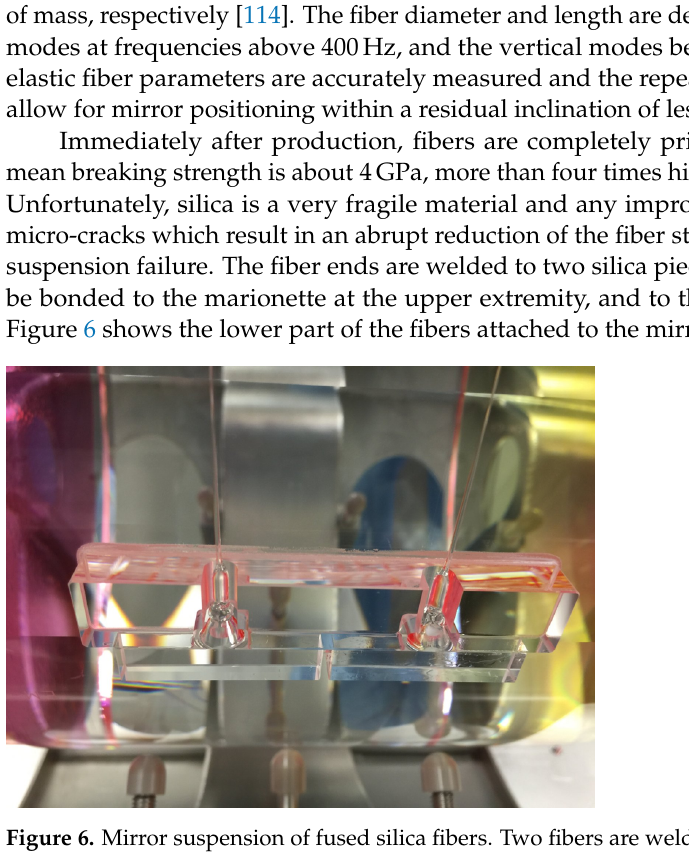
Figure 6. Mirror suspension of fused silica fibers. Two fibers are welded to rectangular silica pieces anchored to another silica rectangular block which in turn is attached to flats worked out in the mirror lateral surface. All the silica surfaces are attached by hydroxide-catalysis bonding. Credit: The Virgo